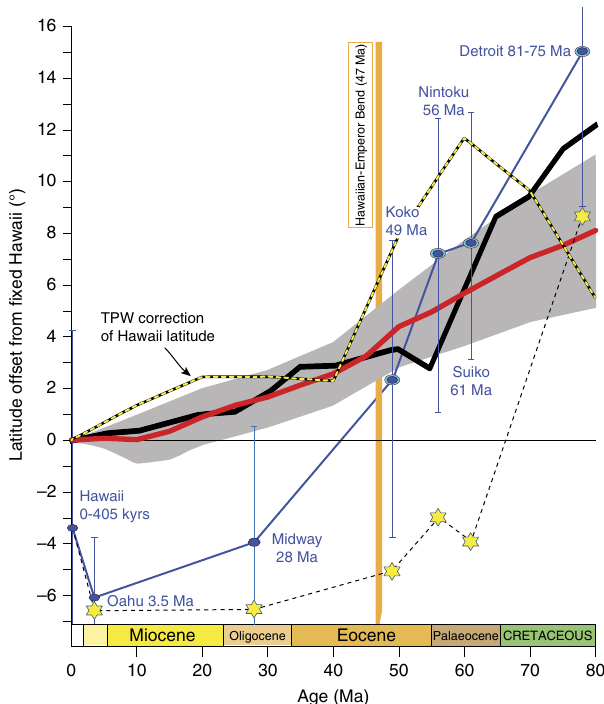
Figure 2 | Latitudes and surface motion of the Hawaiian hotspot. Palaeomagnetically derived latitudes (blue ovals connected with the blue line) from seamounts along the Emperor Chain and islands/atolls along the Hawaiian Chain 17–22,49,50 plotted with 95% confidence bars. The data are shown as latitude offsets from the present latitude of Hawaii (observed latitude minus latitude of Hawaii, 19.4 (cid:2) N). These offsets can reflect hotspot drift, the effect of TPW, non-dipole contributions to the time-averaged geomagnetic field in the vicinity of Hawaii (for example, the inclination anomaly corresponding to a B (cid:2) 3.5 (cid:2) latitude offset in the most recent data ( o 405kyrs) from the Island of Hawaii 30 ), or a combination of thereof (see text). The thick black line with yellow stippling shows TPWcorrections for Hawaii (calculated from ref. 28, see Methods). TPW-corrected latitude offsets (except for Hawaii) are shown as six-pointed yellow stars connected with a dashed line; these were computed by subtracting the values of TPW correction from the observed palaeolatitudes. A newer palaeomagnetic result from Midway reported in abstract form 51 gives a TPW-corrected offset of (cid:2) 3.2 (cid:2) . The palaeomagnetic results are compared with latitudinal estimates of surface motions of the Hawaiian hotspot (Fig. 5a,c) after Doubrovine et al. 28 (thick red line with grey-shaded 95% confidence region) and Hassan et al. 14 (thick black curve, their preferred model